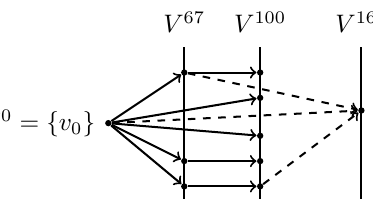
Figure 1: Example of a graph constructed by Expand . The set B contains three hypo- thetical instructions of cost 67, 100 and 167, which implies that nodes at distance 167 from the root v 0 can be reached from nodes in V 100 , V 67 , or V 0